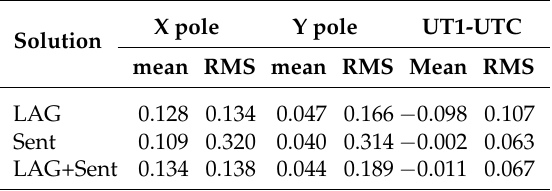
Table 4. Mean offsets and RMS values of the estimated X, Y pole coordinates (in mas) and UT1-UTC (in ms) in reference to the a priori IERS-CO4-14